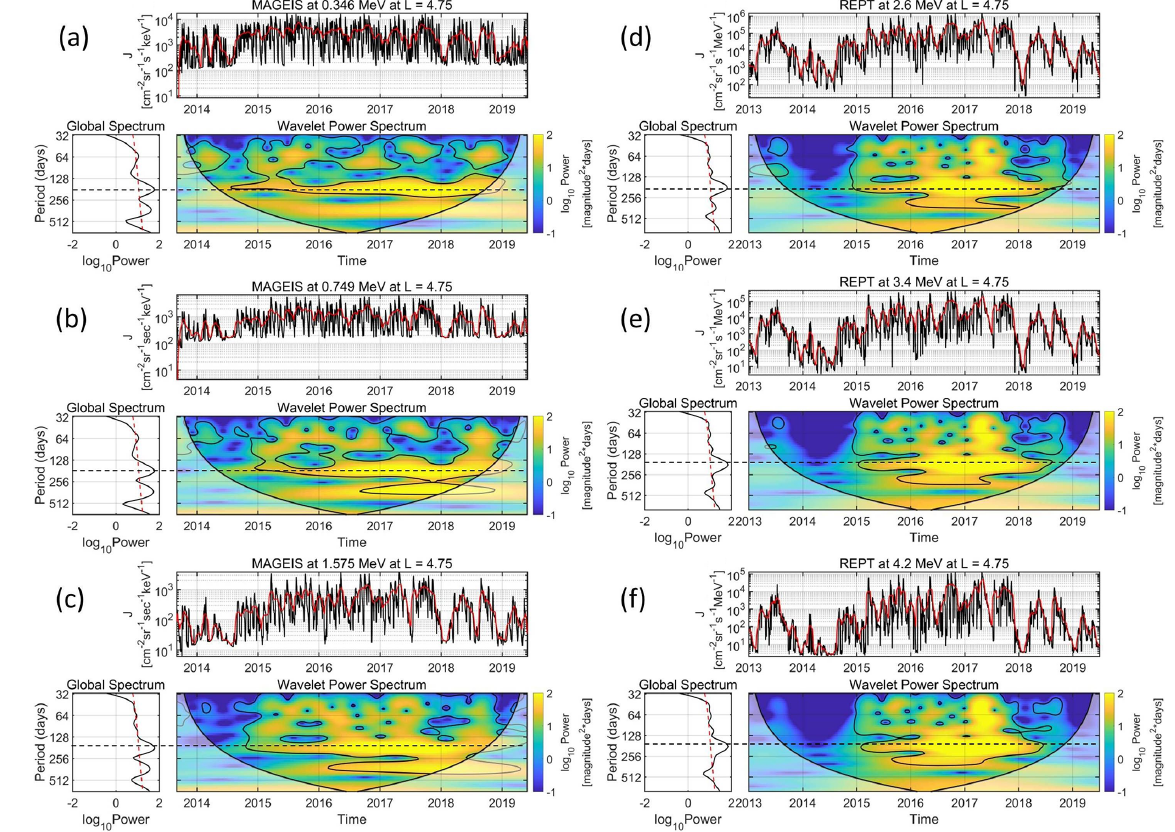
Figure 4. Time series, wavelet power (CWT) and global wavelet spectra of (a) 0.346, (b) 0.749, (c) 1.575, (d) 2.6, (e) 3.4 and (f) 4.2MeV electron fluxes at 4 . 5 < L < 5; the red lines are a 28d moving average smoothing of the time series. The wavelet power display is color- coded, with yellow corresponding to the maxima; the black line is the cone of influence of the spectra, where edge effects in the processing become important, while the black contours correspond to the 95% confidence level. The dashed red lines in the global spectra represent the 95% confidence level of the global power. The horizontal dashed (black) lines highlight the